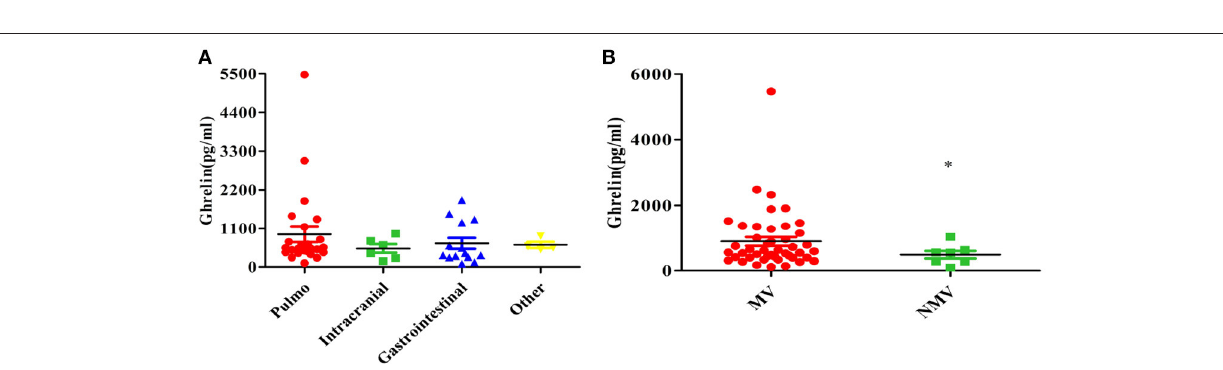
Frontiers in Pediatrics |